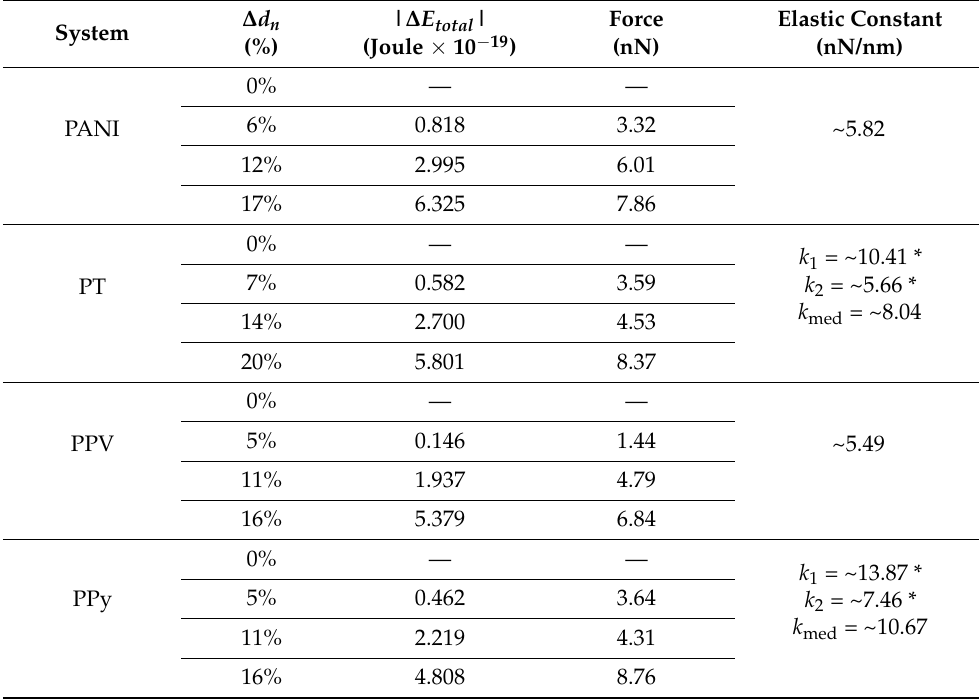
Table 2. Relative changes in the total energies ( ∆ E total ) and estimated values for the forces ( F ) and average elastic constants ( k ). System